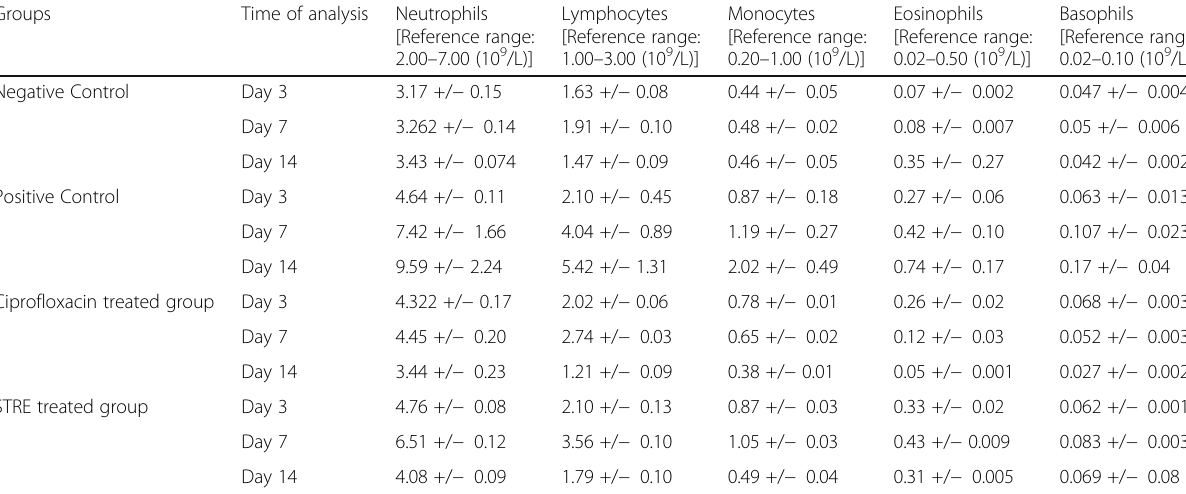
Table 1 Haematological analysis of study animals